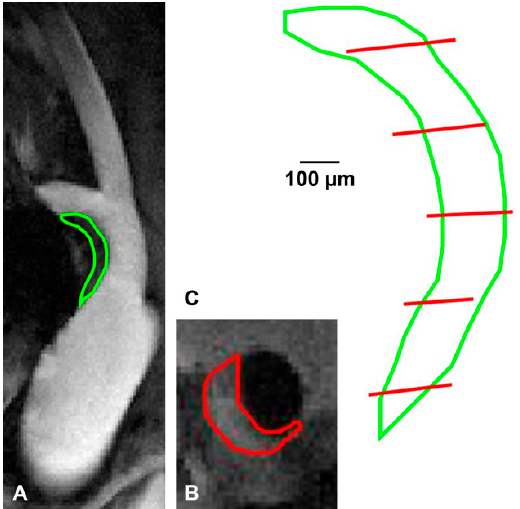
Figure 4. Validation of plaque ROI. ( A ) Example of plaque ROI drawn on BCA view as used for analysis. ( B ) Example of plaque ROI on axial view black-blood image of the same mouse. ( C ) Intersections of axial ROIs with the BCA view image plane (red) superimposed on the longitudinal plaque ROI (green).